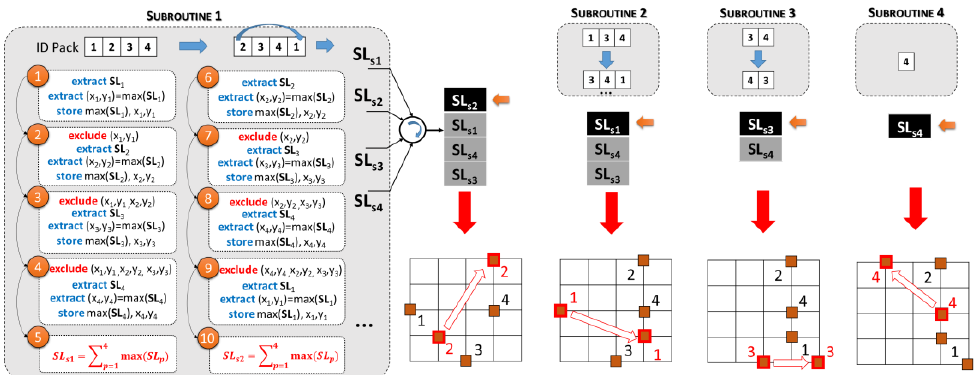
Figure 6. QCL Algorithm with expanded subroutines and displacement actions example.